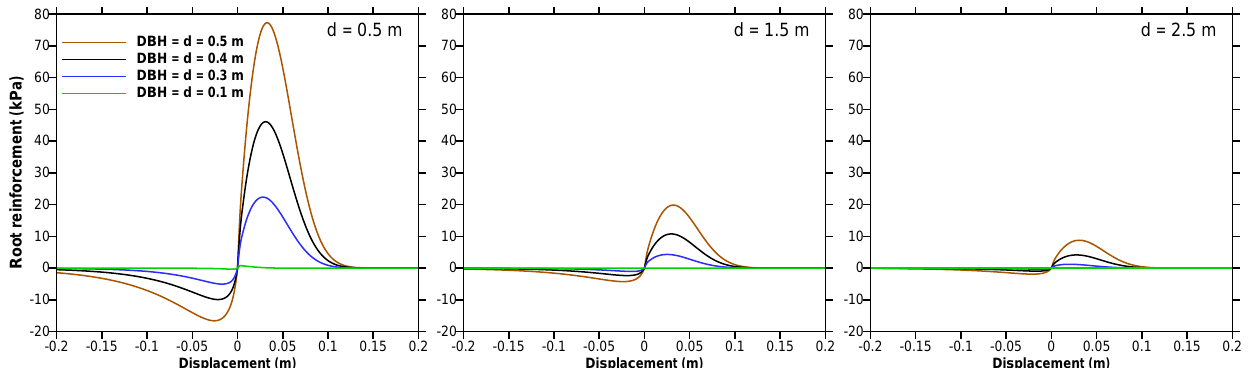
Figure 4. Root reinforcement as a function of bond elongation for different tree diameters (DBH) and different distances from the tree trunk ( d ). Positive displacement indicates tension; negative compression.